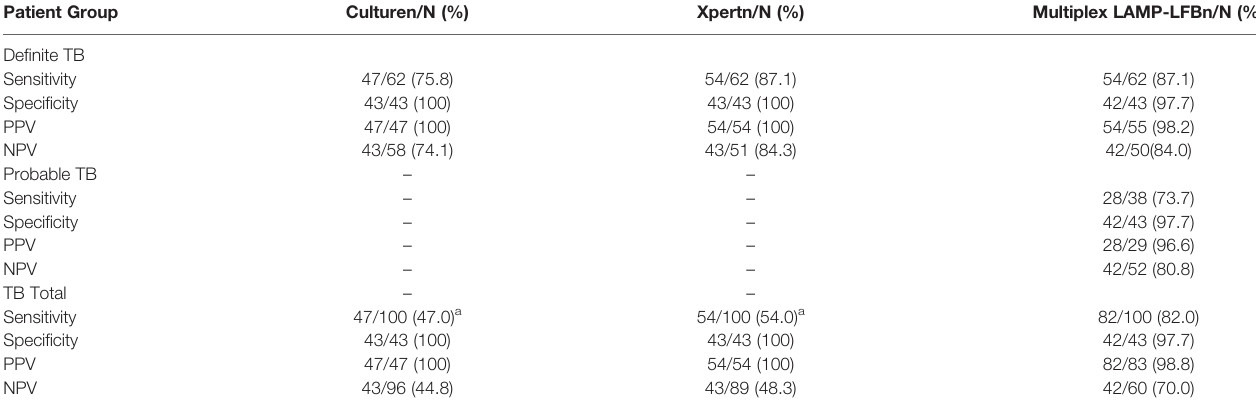
TABLE 3 | Performance of different methods for TB